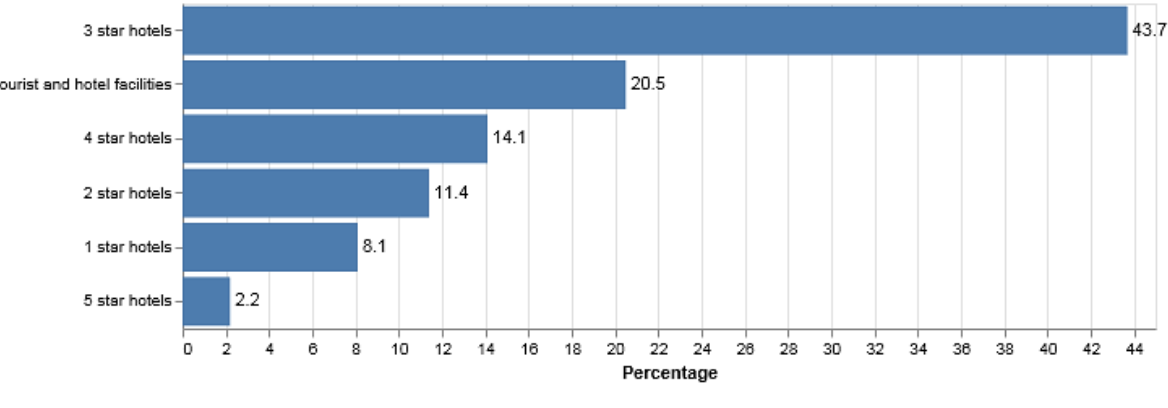
Figure 3. Percentage breakdown of hotels in the Pisan municipality